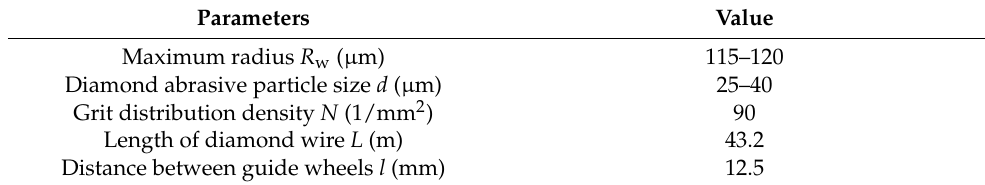
Table 2. Parameters of the diamond wire.